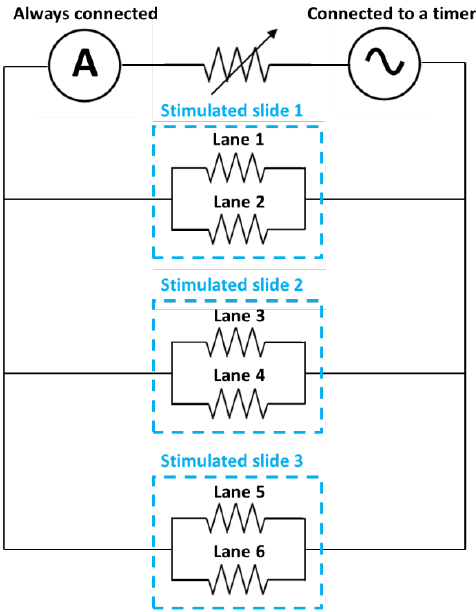
Figure 5. Electrical diagram of the different elements used. Six PLA-PPy-Au lanes were connected in parallel using three different slide chambers so that the same current circulated through each lane. An AC generator at a given frequency and with a sinusoidal signal fed the circuit and the circulating current was measured in real time with an ammeter connected in series. A potentiometer was also connected in series to raise the total electrical resistance of the circuit in order to use a voltage that was not excessively low for the voltage generator.